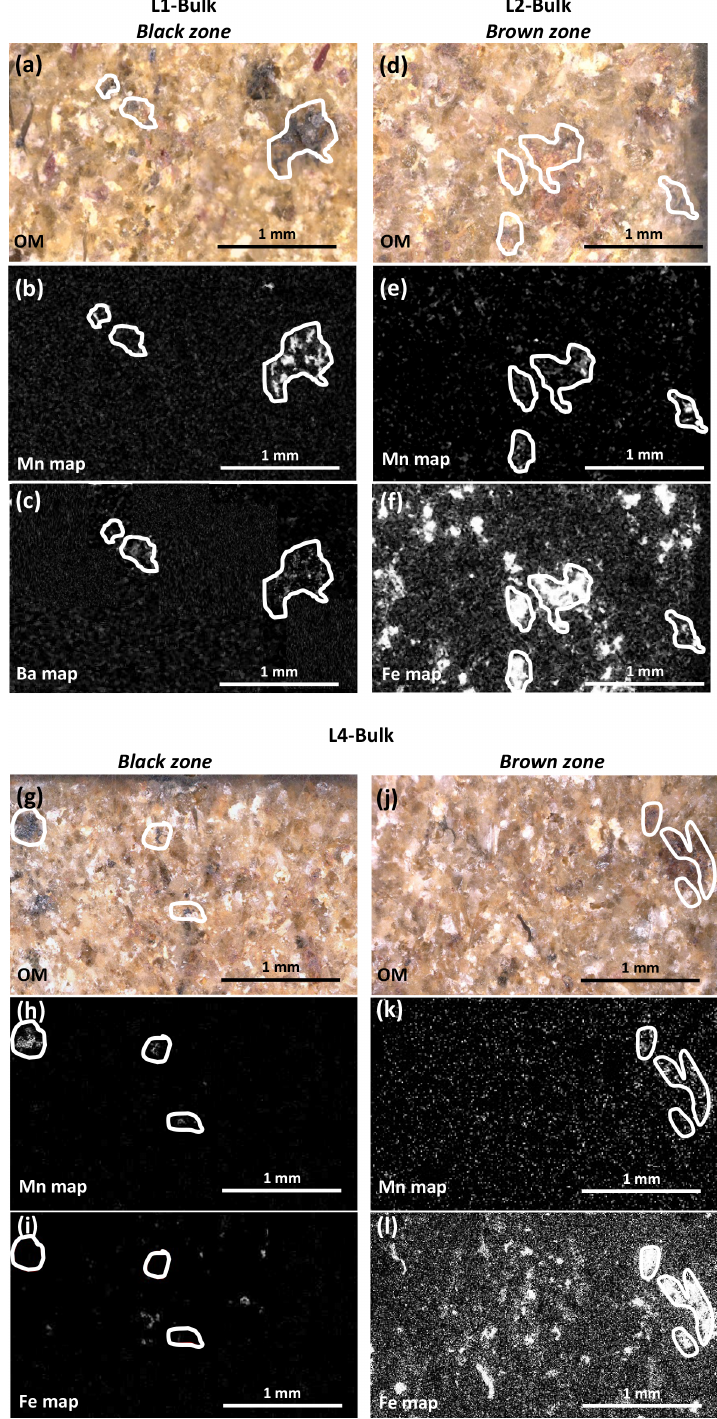
Figure 5. Optical images (a, d, g, j) and EDS maps (b, c, e, f, h, i k, l) obtained on selected zones from the bulks of L1 (a, b, c) , L2 (d, e, f) , and L4 (g, h, i, j, k, l) . In the chemical maps, bright areas indicate high elemental concentrations (Mn: b, e, h, k ; Ba: c ; Fe: f, i, l ). Mn-rich zones are outlined in white to reveal possible positive correlations with other